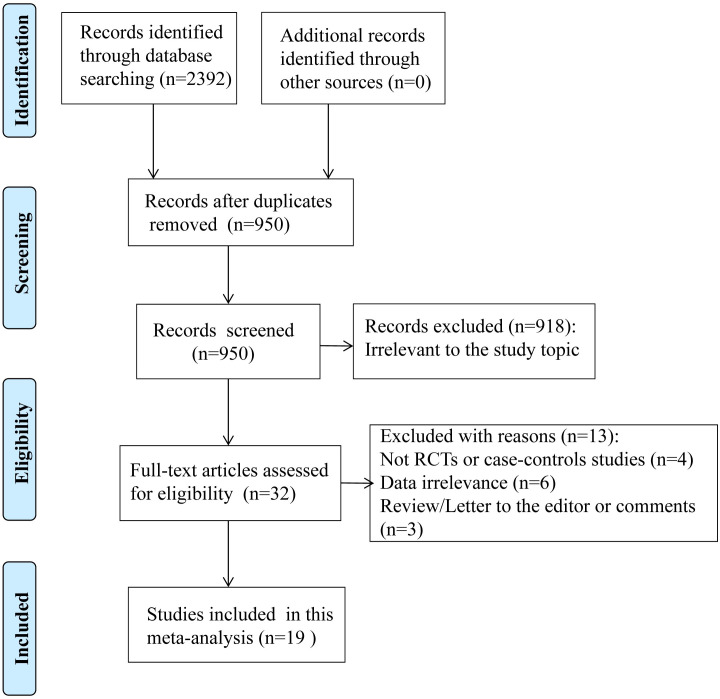
Flow diagram of studies included in the meta-analysis.PRISMA flow diagram showing the number of articles identified and evaluated during the review.